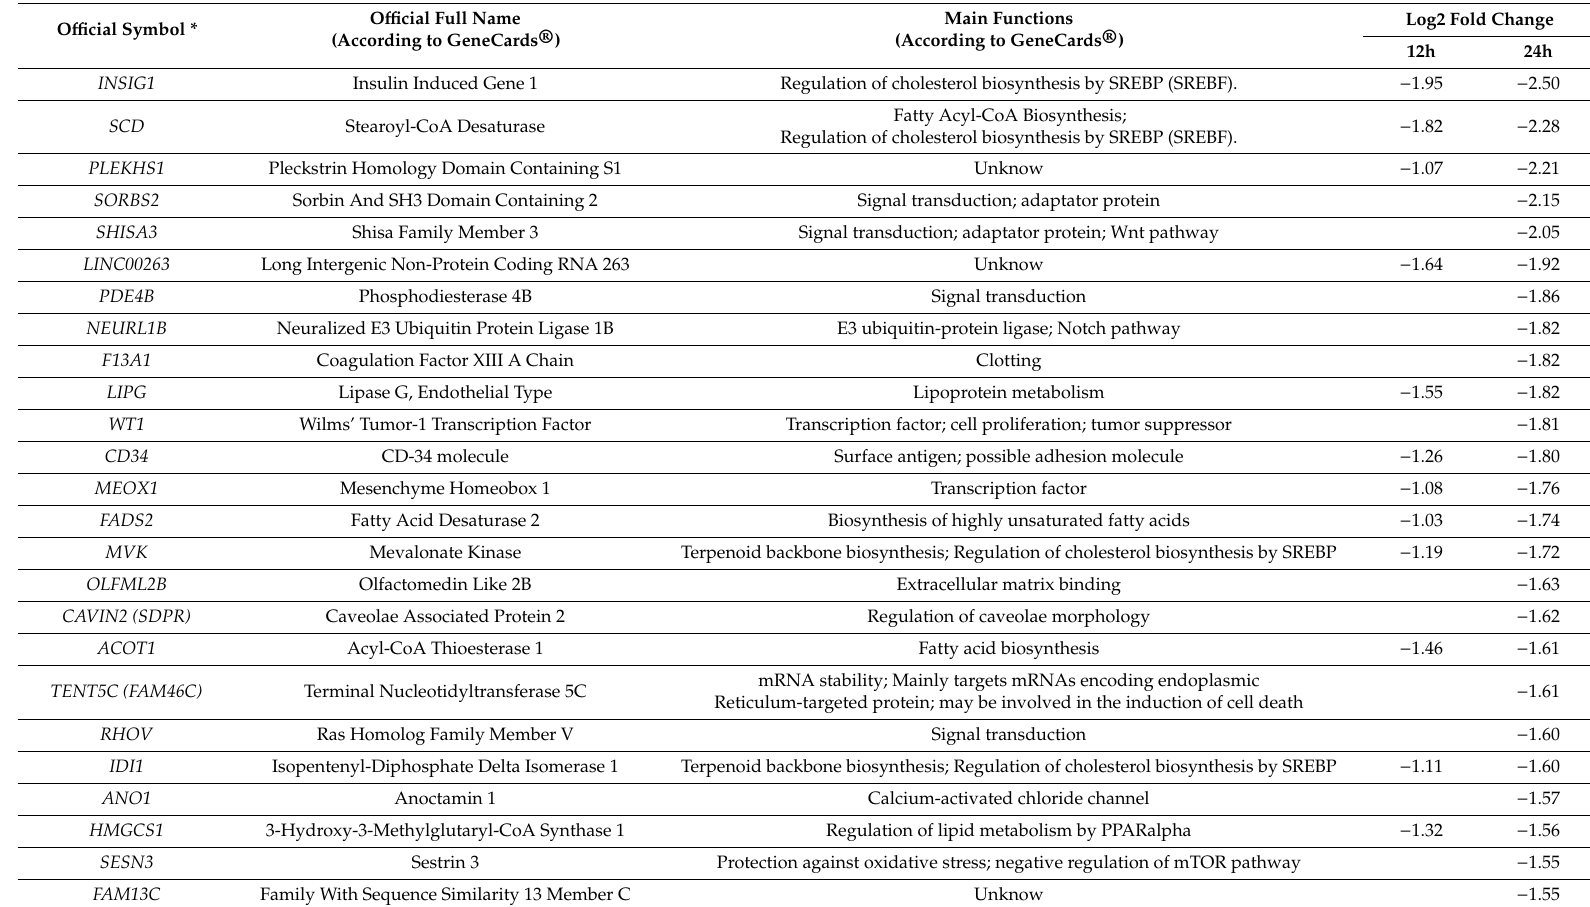
Table 2. Top 25 of DHA-downregulated